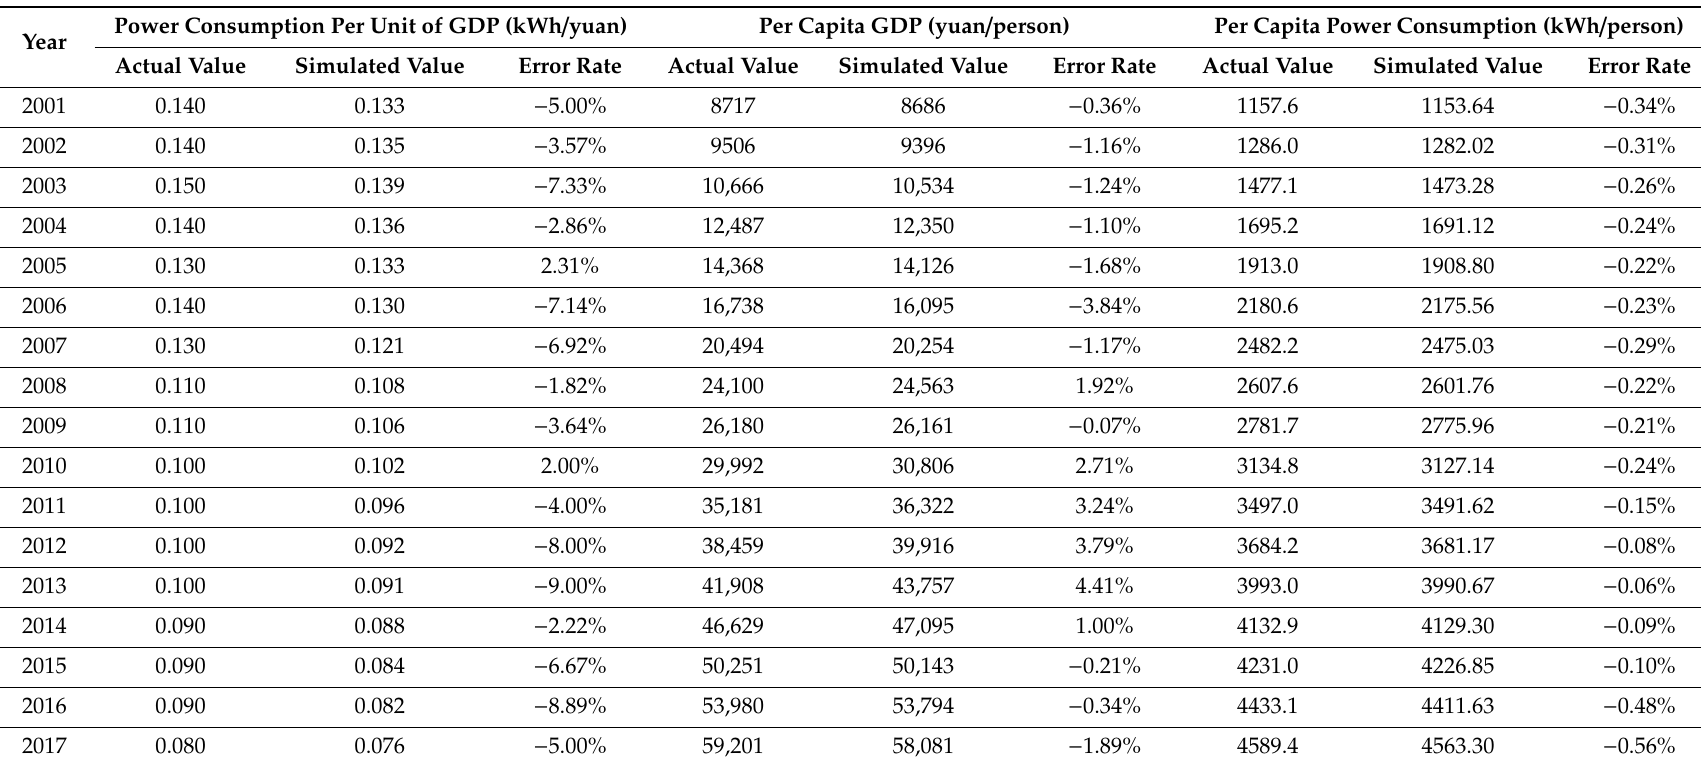
Table 1. Comparison of simulated values and actual values of